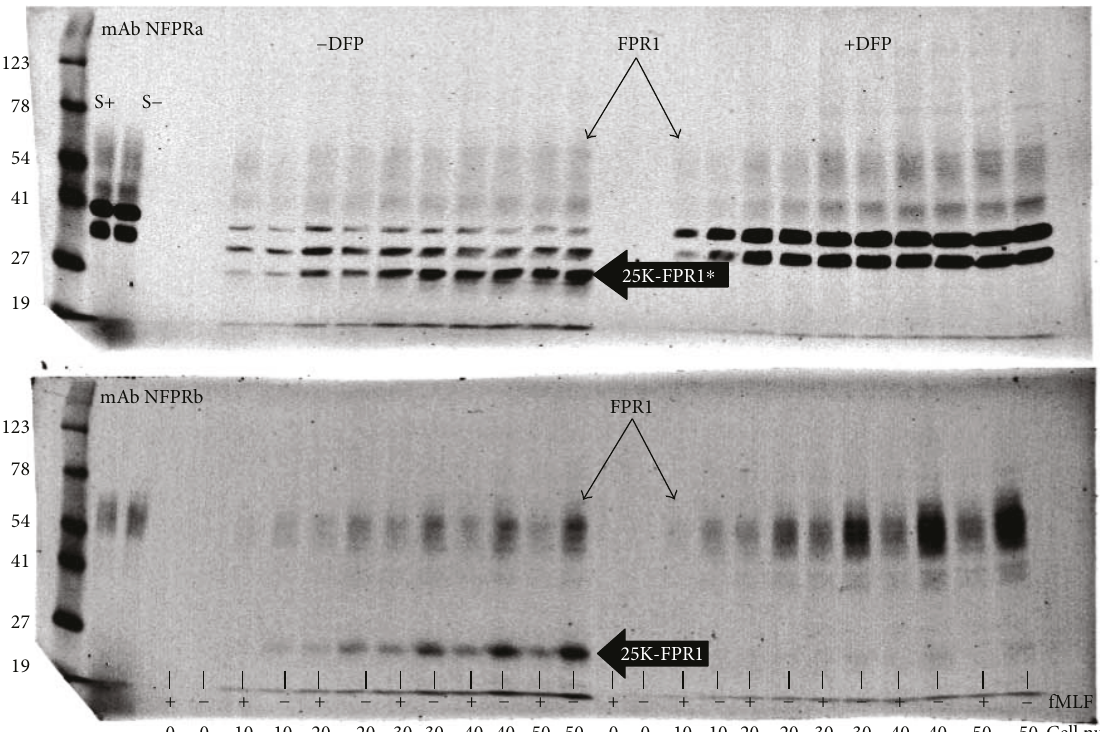
Figure 1: Cell-penetrating serine protease inhibitor diisopropyl fl uorophosphate blocks FPR1 cleavage in solid phase assay of FPR1 phosphorylation. Twenty-four wells of a 96-well microtiter plate were loaded with 0 to 50 × 10 4 PMN. Cells had been treated with control (left half) or 3mM DFP-containing bu ff er (right half) for 5min as described in Section 2. The plated PMN were exposed to 1 μ M fMLF in RPMI or vehicle control and allowed to incubate for 10min at 37 ° C before quenching and washing the wells with 200 μ L of ice-cold DPBS followed by extraction as described in Section 2. 40 μ L of the fi nal extract (2.7 × 10 4 , 5.3 × 10 4 , 8 × 10 4 , 10.7 × 10 4 , and 13.3 × 10 4 cell equivalents/lane) was then loaded on two 28-well SDS-poly acrylamide gels, immunoblotted, and developed with NFPRa (upper) or NFPRb (lower) as described in Section 2. Relative molecular mass markers are labeled to the left of the blot. In the two leftmost sample lanes, 1 μ M fMLF-exposed (S+) or unexposed (S − ) suspension cells prepared as previously described using a comparable cell equivalent load were run as comparative controls. The broad band, of molecular weight ranges 50 to 70 kDa and marked by the two diagonally pointing, single-headed thin arrows, identi fi es FPR1. The thick, horizontal arrow labeled 25K-FPR1 ∗ upper and 25K-FPR1 shows the position of the putative 25kDa fragments of FPR1. This species is clearly absent in DFP-treated PMN. The calculated Mr values of the signi fi cant bands are FPR1 =61.4, FPR2 45.3, 39K 39.7, 35 K 34.7, and 25K 25.6kDa. Data shown is representative of 2